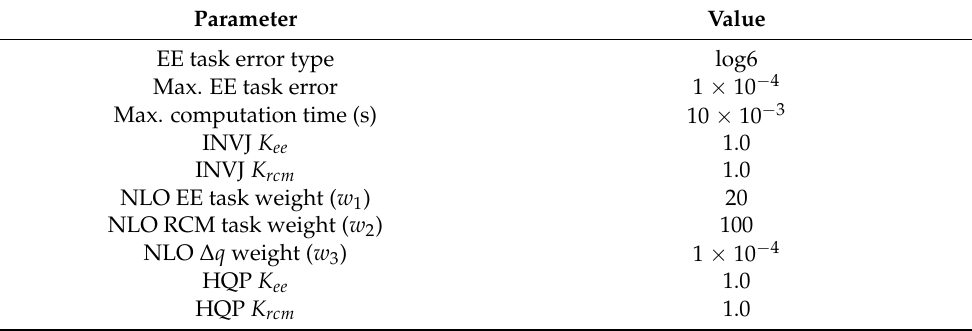
Table 1. Parameters used for the unconstrained inverse kinematics benchmark. Parameter Value